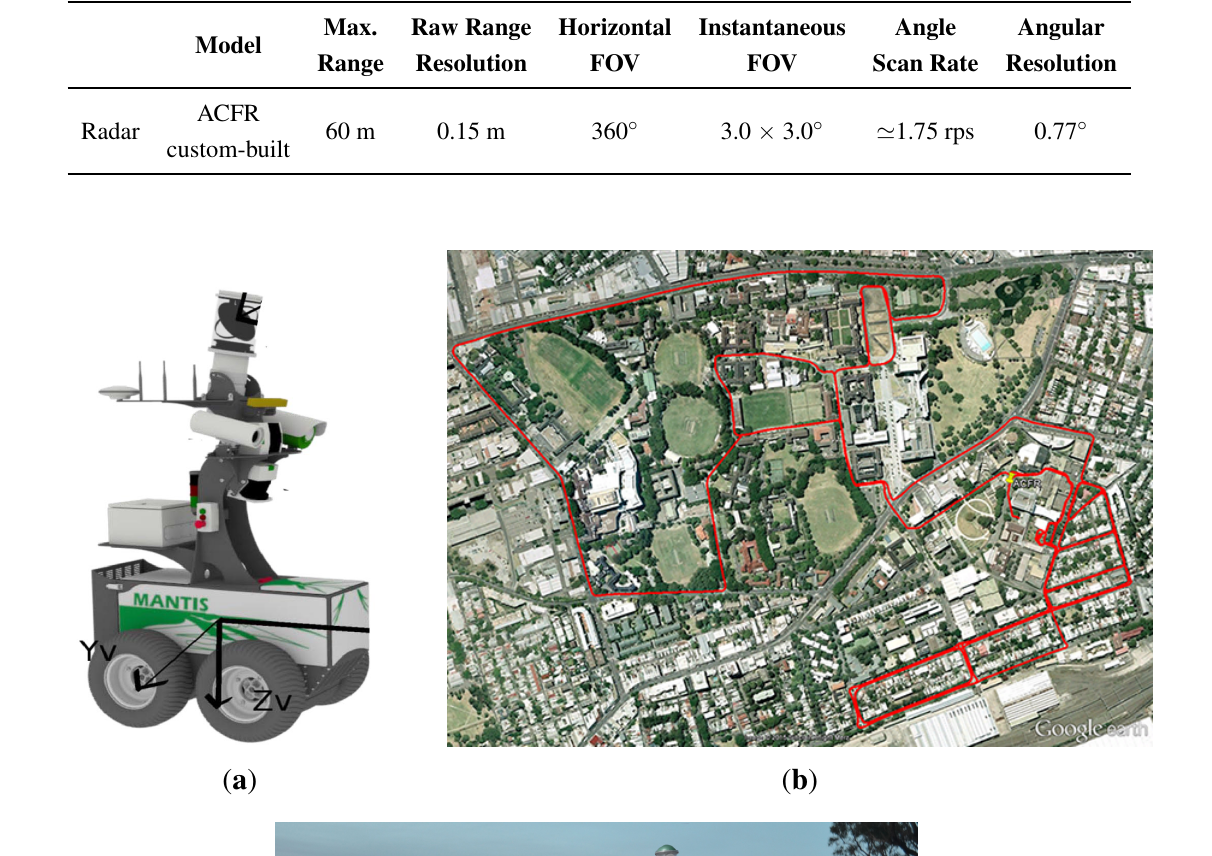
Table 2. HSS radar technical properties.